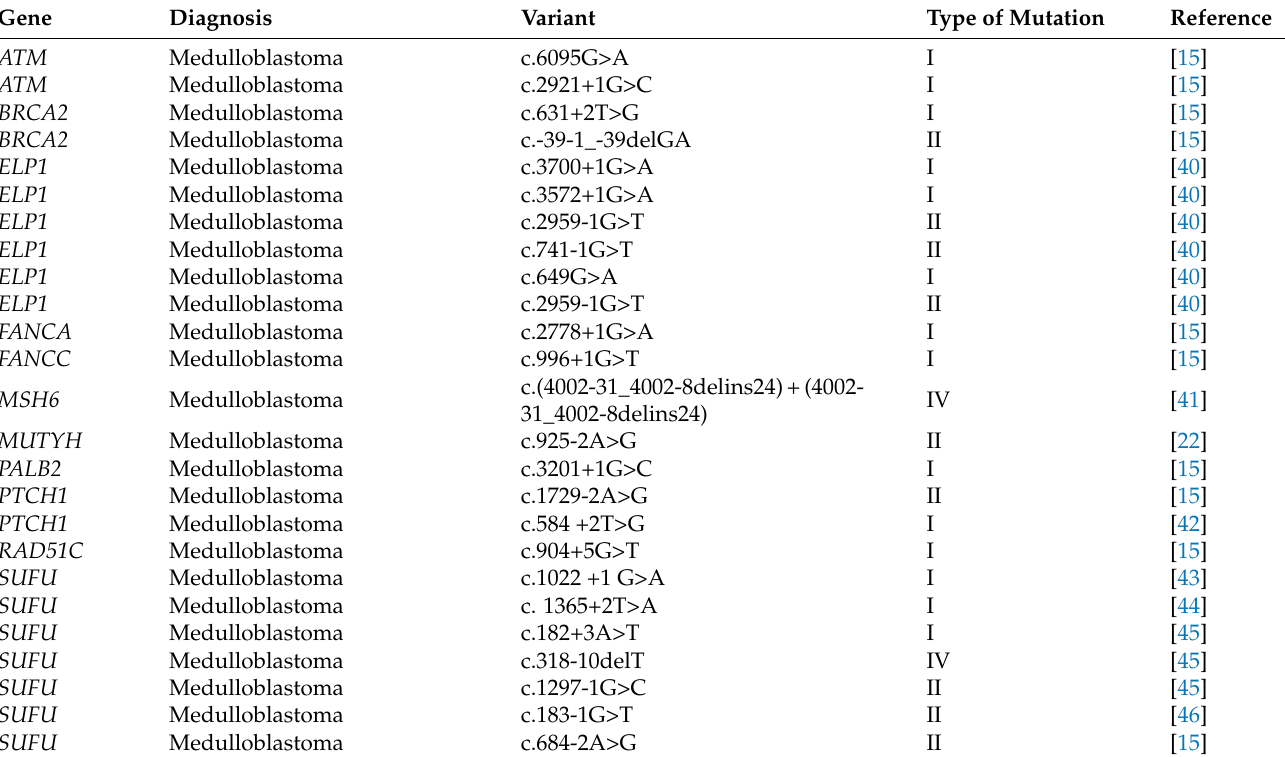
Table 2. Germline pathogenic splice variants found in pediatric patients with CNS